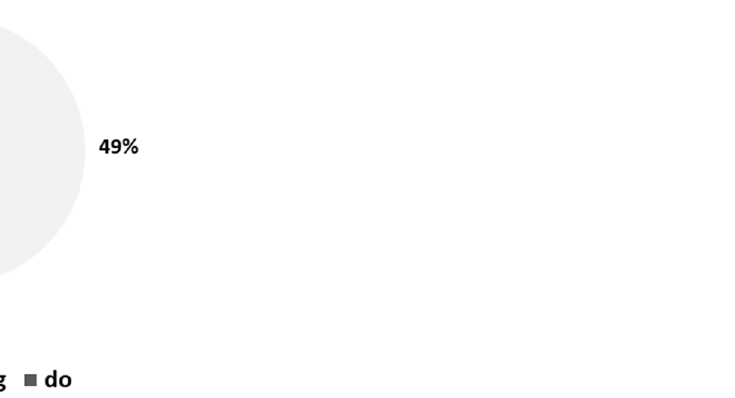
Figure 2. Average percentage of verbal responses in the present sample of interviews between humanist chaplains and hospital clients; n f —empathic following response; n u —empathic understanding response; d a —allowed directive response; d u —unallowed directive response.